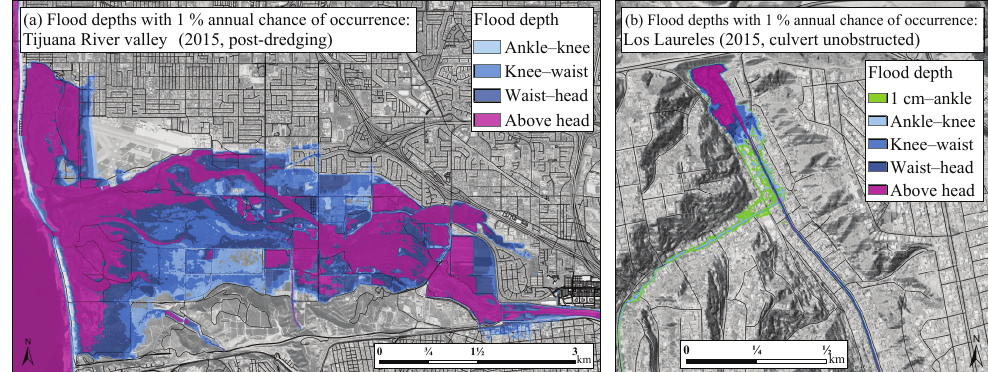
Figure 3. (a) 1% annual exceedance probability (AEP) flood depths in the Tijuana River valley. Mapped flood depths result from either storm tides, canyon flows, or Tijuana River discharges (Appendix A1). The elevation data reflect 2015 topography, after dredging of the Tijuana River channel near the US–MX border. (b) 1% AEP flood depths in Los Laureles. Mapped flood depths are caused by streamflows from local precipitation, assuming that the culvert was unobstructed during the duration of the flood. The depth ranges are 0.11–0.45m for ankle to knee, 0.45–1.0m for knee to waist, 1.0–1.69m for waist to head, and greater than 1.69m for above head